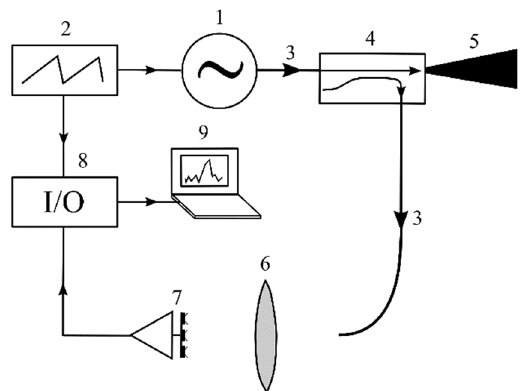
Figure 2. A schematic representation of the 94 GHz imaging system with a direct-conversion 1 × 3 FPA receiver. (1) W-band BWO, (2) function generator, (3) rectangular waveguides, (4) directional coupler, (5) horn antenna, (6) dielectric lens, (7) array receiver, (8) I/O device, and (9) laptop.